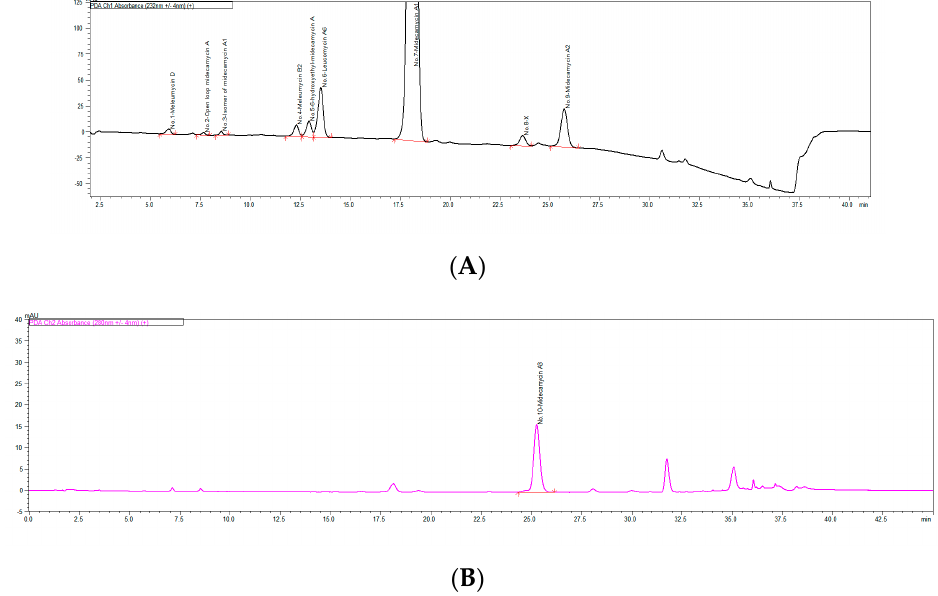
Figure 1. UV chromatogram of midecamycin: ( A ) Detection wavelength of 231 nm (the peaks, in the following order, are meleumycin D, open-loop midecamycin A, isomer of midecamycin A 1 , meleumycin B 2 , 6-hydroxyethyl-midecamycin A, leucomycin A 6 , midecamycin A 1 , X, and midecamycin A 2 ). ( B ) Detection wavelength of 280 nm (the peak is midecamycin A 3 ). All of the structures are listed in Table 1.